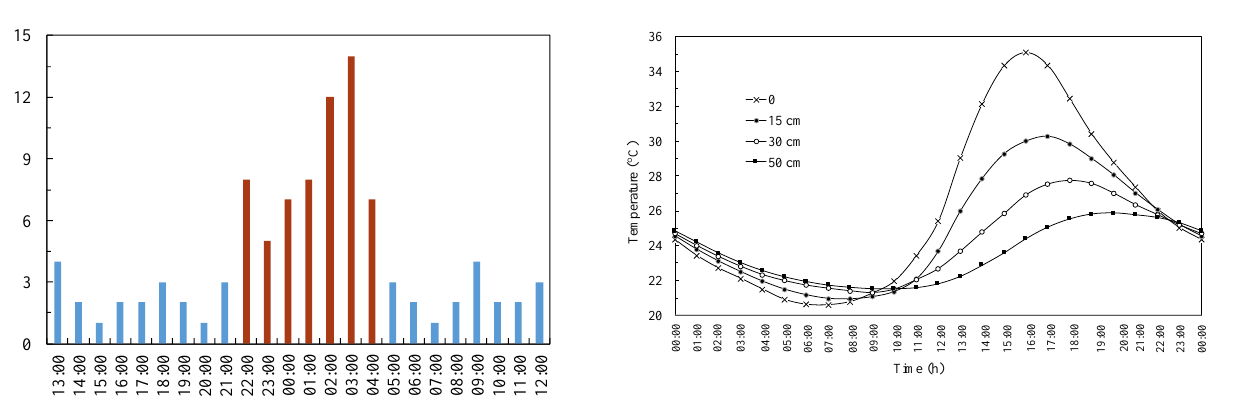
Figure 9. Daily soil temperature variation in loess areas of China in summer. Data are from field monitoring from April 2014 to Septem- ber 2017 in Linxian County, Shanxi,